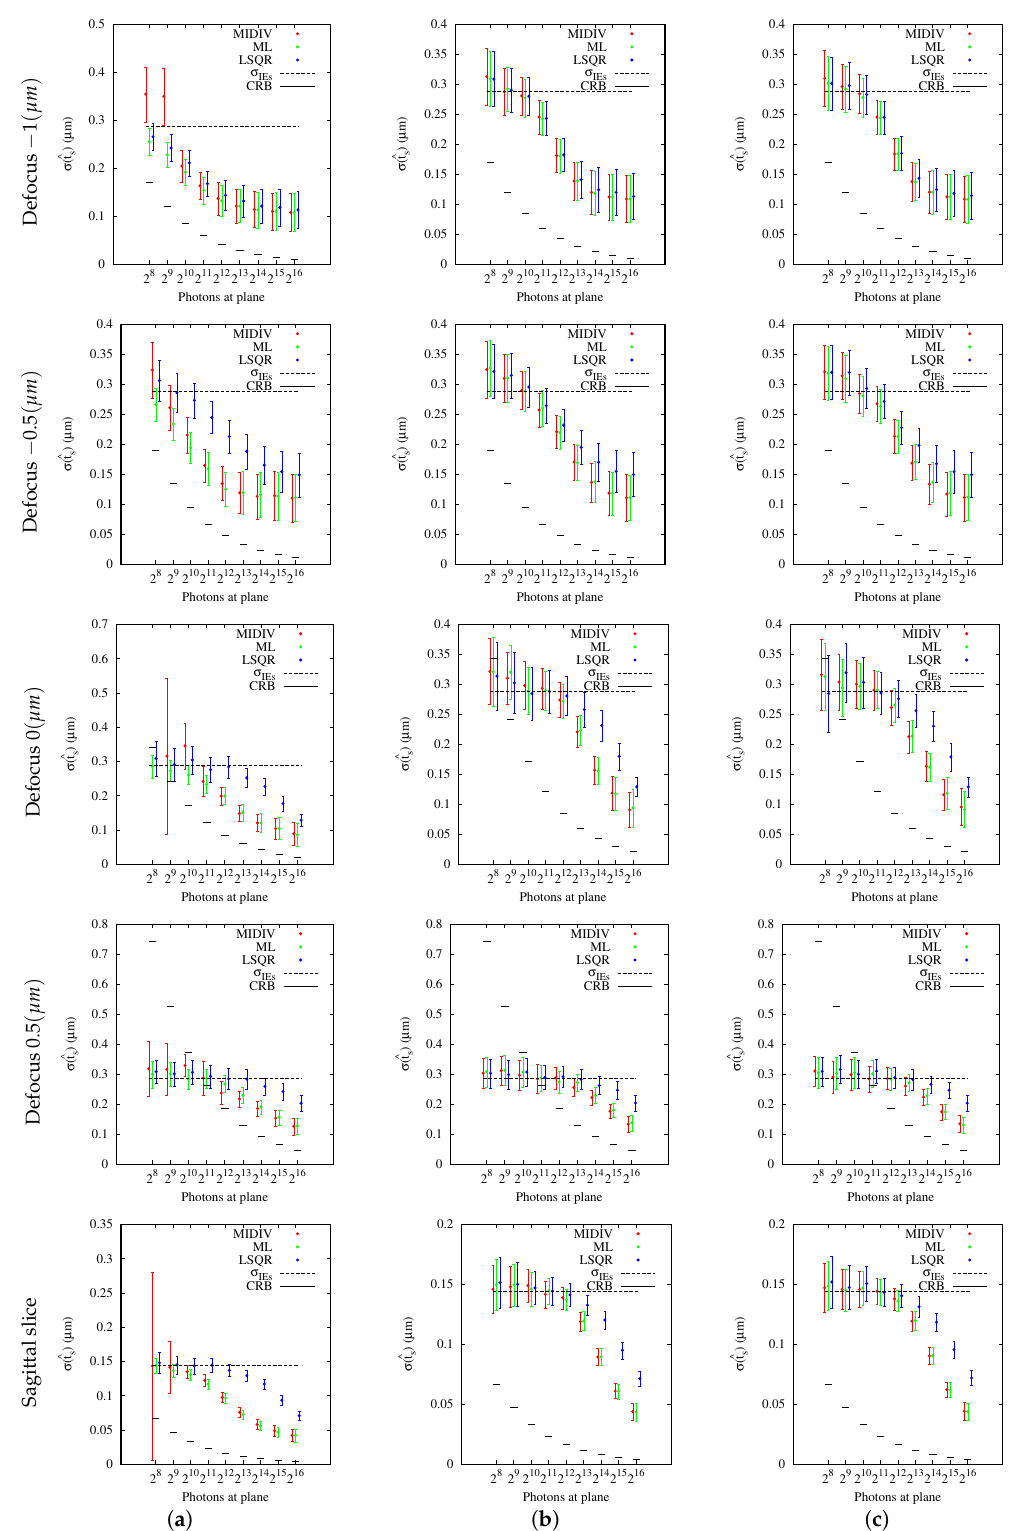
Figure 9. Precision measurements of the methods: MIDIV (red), ML (green) and LSQR (blue). The dashed line represents the theoretical standard deviation of the initial estimates ( σ IEs ). The Cramer–Rao bound (CRB) is shown in solid line segments for each level of intensity. Precision results are presented as the point estimates of the standard deviations of the t s estimations and their confidence intervals. ( a ) NCI; ( b ) NCII; ( c )